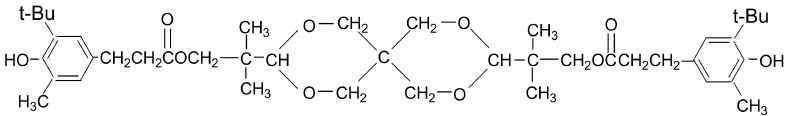
Figure 1. Chemical structure of hindered phenol 3,9-bis[1,1-dimethyl-2-{b-(3-tert-butyl-4-hydroxy-5 -methylphenyl)propionyloxy}ethyl]-2,4,8,10-tetraoxaspiro-[5,5]-undecane